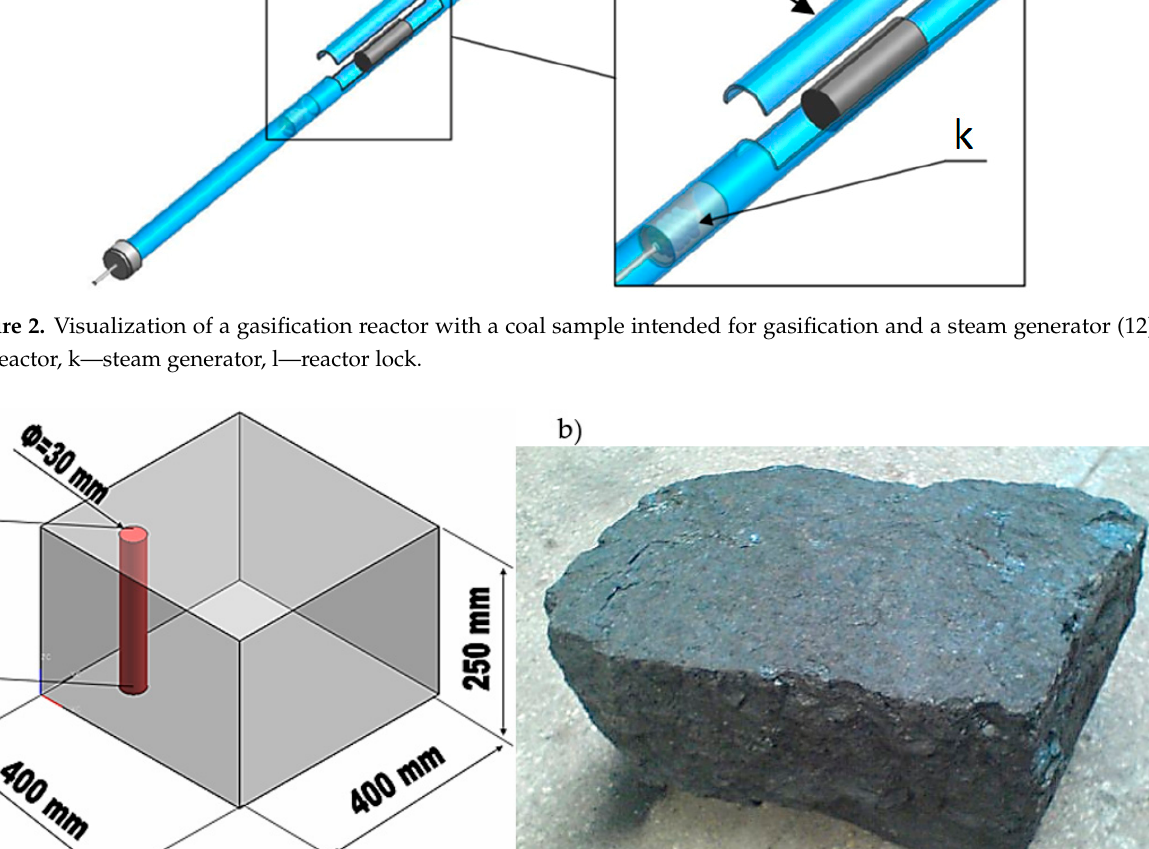
Figure 3. Coal sample: ( a )—view of the basic dimensions of a coal sample, ( b )—the real sample of coal.